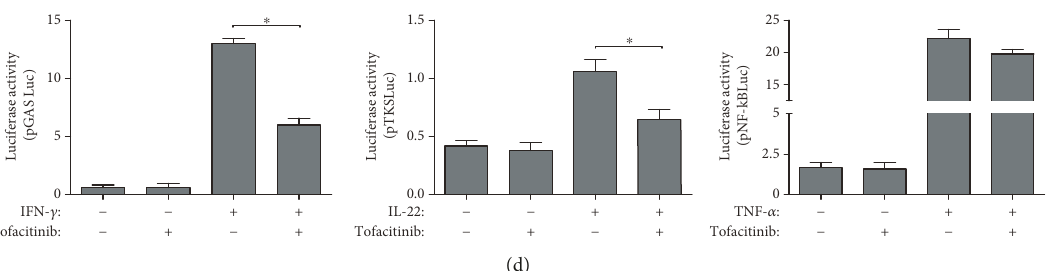
Figure 1: Tofacitinib inhibits IFN- γ - and IL-22- but not TNF- α -induced molecular signaling in psoriatic keratinocytes cultures. (a) Protein extracts obtained from psoriatic keratinocytes pretreated or not with vehicle alone or the indicated doses of tofacitinib, and then stimulated or not with IFN- γ for the indicated time periods, were subjected to immunoprecipitation for IFN- γ R α , JAK1, or JAK2 and Western blotting analysis by using anti-phosphotyrosine Ab to detect IFN- γ R α , JAK1, or JAK2 phosphorylation. Filters were stripped and reprobed with anti-IFN- γ R α , JAK1, or JAK2 Abs. Phosphorylated and unphosphorylated forms of STAT1, STAT3, and ERK1/2 were monitored in keratinocytes by WB analysis. (b) Protein extracts were obtained from keratinocytes pretreated or not with tofacitinib in the presence of IL-22 for the indicated time periods and were subjected to immunoprecipitation for IL-22R1, TYK1, or JAK2 and, then, WB analysis by using anti-phosphotyrosine Ab to detect IL-22R1, TYK1, or JAK2 phosphorylation. Filters were stripped and reprobed with anti-IL-22R1, TYK1, or JAK2 Abs. Phosphorylated and unphosphorylated forms of STAT1, STAT3, and ERK1/2 were also monitored in keratinocytes by WB analysis. (c) Protein extracts were obtained from keratinocytes pretreated or not with tofacitinib in the presence of TNF- α for 15min and then analysed by WB analysis to detect basal or phospho-I κ B α , basal or phosphor-p65 subunit of NF- κ B, and phosphorylated and unphosphorylated forms of STAT3 and ERK1/2. Graphs in (a), (b), and (c) represent densitometric analyses of the indicated proteins shown in representative WB. Data are expressed as mean ± SD fold induction (F.I.) calculated relatively to the untreated samples, which were given a value of 1. ∗ p < 0 01 , ∗∗ p < 0 05 . (d) Psoriatic keratinocyte cultures transiently transfected with a STAT1-, STAT3-, or NF- κ B-responsive plasmids, termed, respectively, pGAS-Luc, pLucTKS3, or pNF- κ B-Luc were treated with 5 μ M tofacitinib or vehicle alone for 2h and then stimulated with IFN- γ , IL-22, or TNF- α for 8 h prior to assay Fire fl y luciferase activity on cellular extracts. Data are expressed as Fire fl y luciferase values normalized to Renilla luciferase and micrograms of proteins and are shown as mean +SD of n = 6 samples pooled from two experiments. ∗ p < 0 01